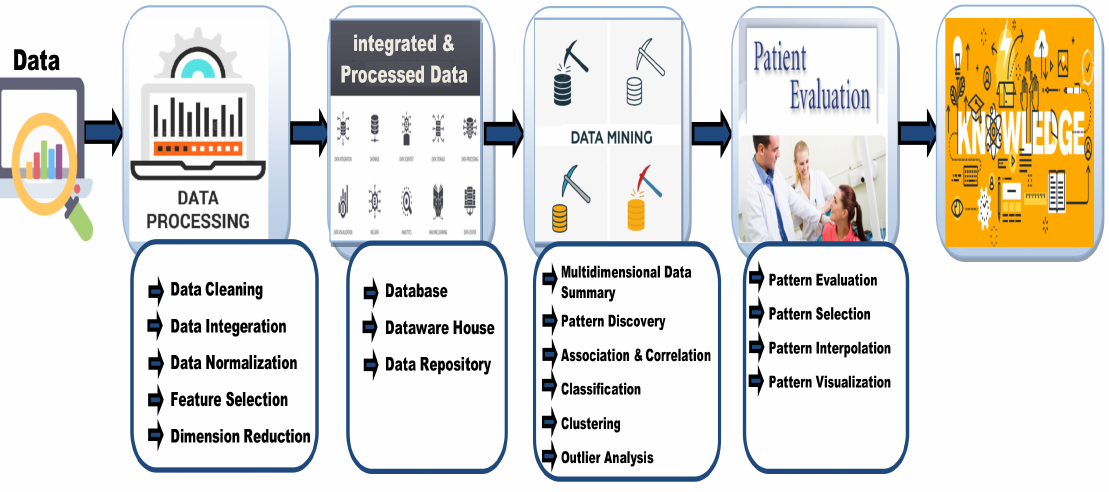
Figure 2. The knowledge discovery